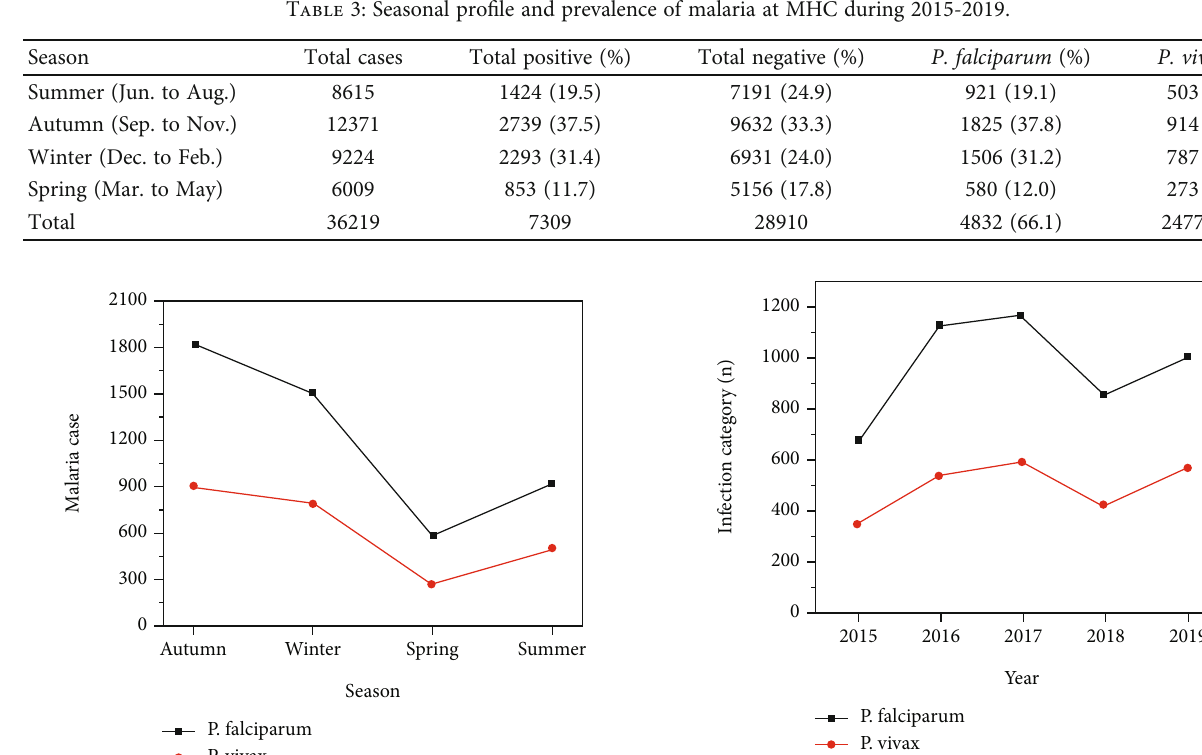
Figure 3: Side positive cases by infection category at MHC, northwest Ethiopia, from